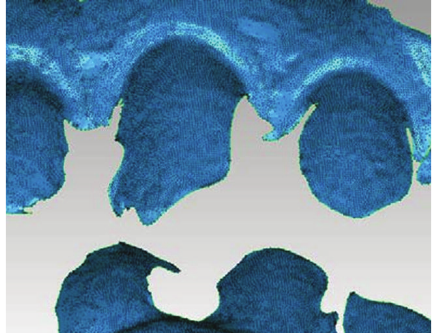
Figure 6: A typical 3D camera frame at 80 𝜇 m point spacing.